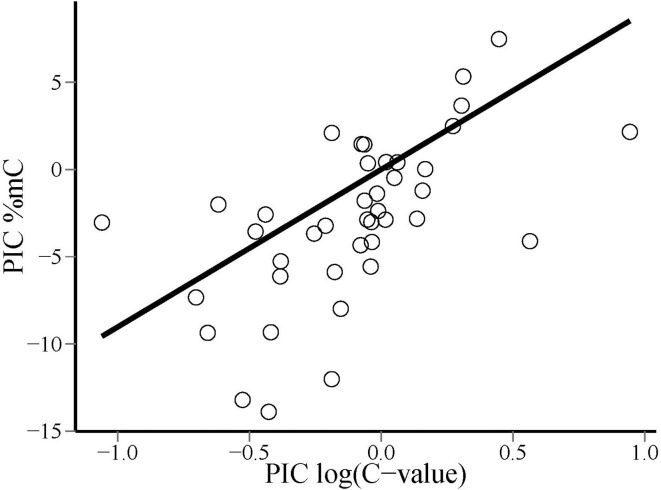
Bivariate scatterplot of the relationship between phylogenetically independent contrasts in global DNA cytosine methylation (PIC %mC) and log10-transformed genome size [PIC log(C-value)], and least squares-fitted regression line through the origin.